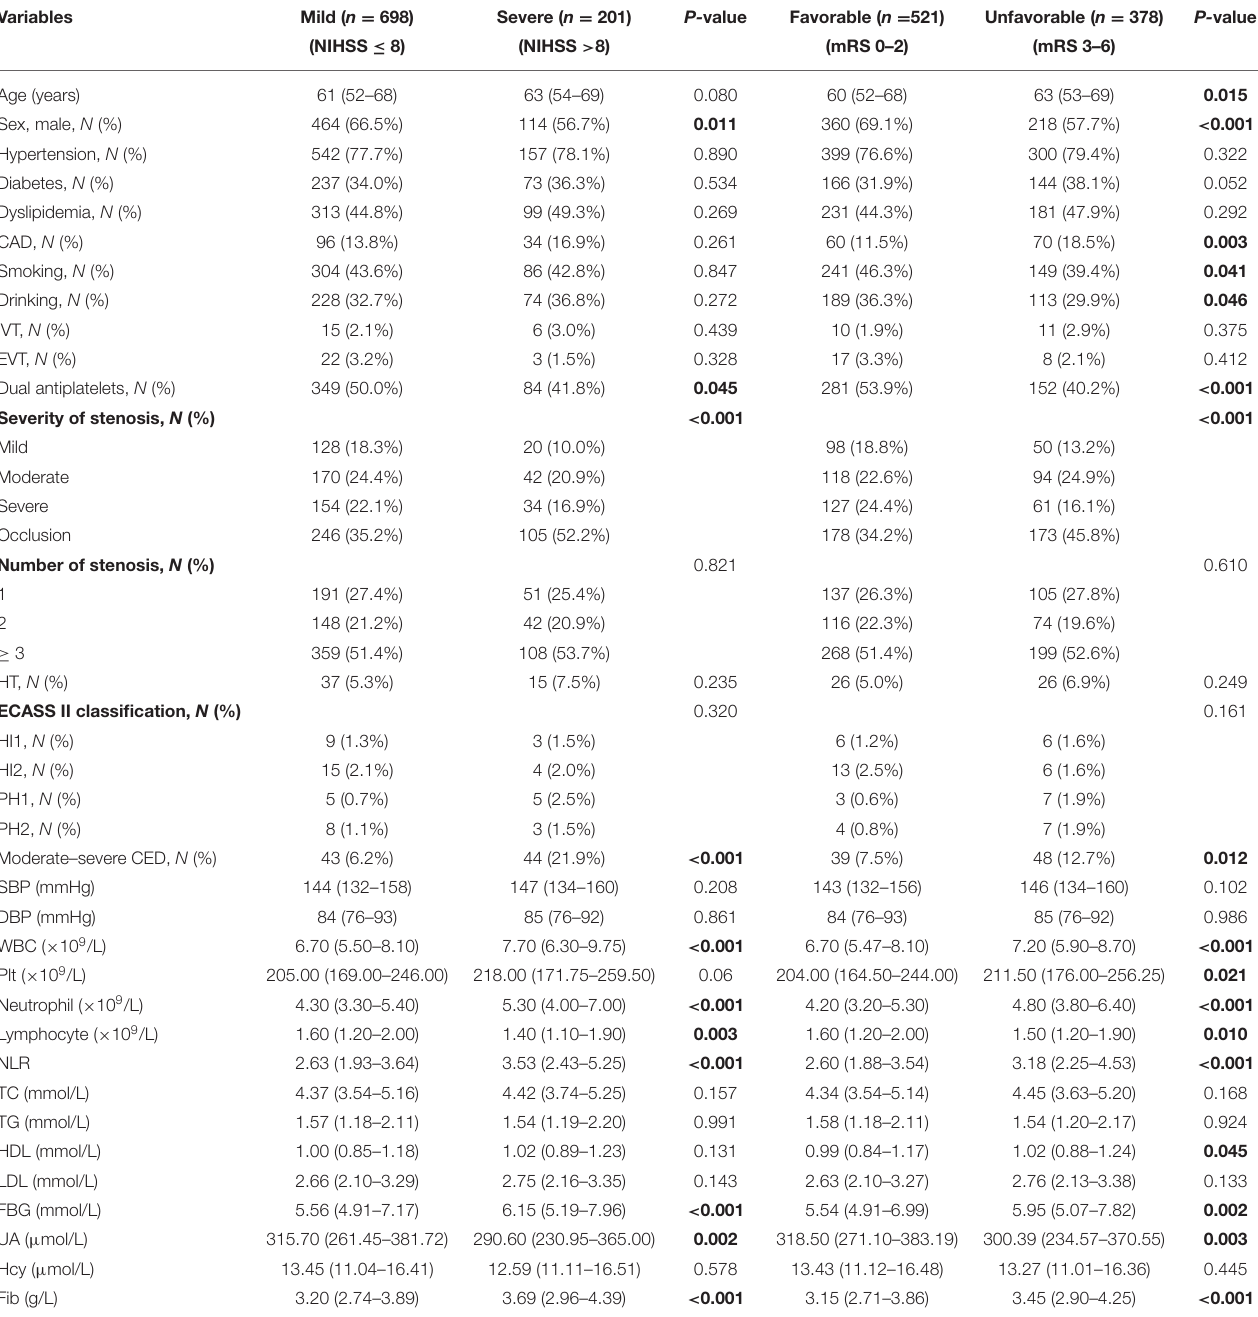
TABLE 2 | Clinical characteristics of sICAS patients according to the initial stroke severity and short-term prognosis.